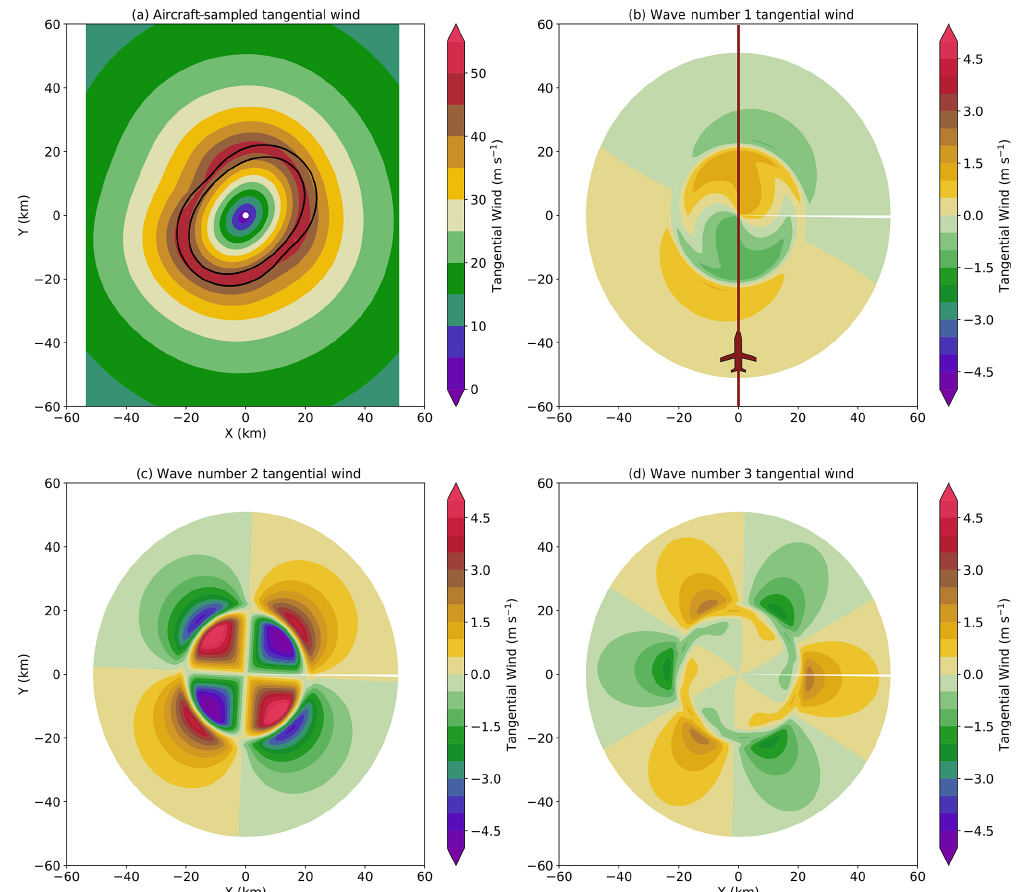
Figure 8. (a) Idealized dual-Doppler tangential wind speed retrieved from a straight flight pass through propagating wave number 2 asymme- try (color in ms − 1 ); the 45ms − 1 contour of prescribed, time-averaged wave number 2 is shown in black. The initial phase of the propagating wave number 2 tangential wind is oriented from east to west, and the final phase is oriented from north to south, resulting in a time-averaged southwest to northeast orientation. (b) Wave number 1 and the aircraft flight track from south to north, (c) wave number 2, and (d) wave number 3 tangential wind components retrieved by the Fourier decomposition of the tangential wind field shown in panel (a)